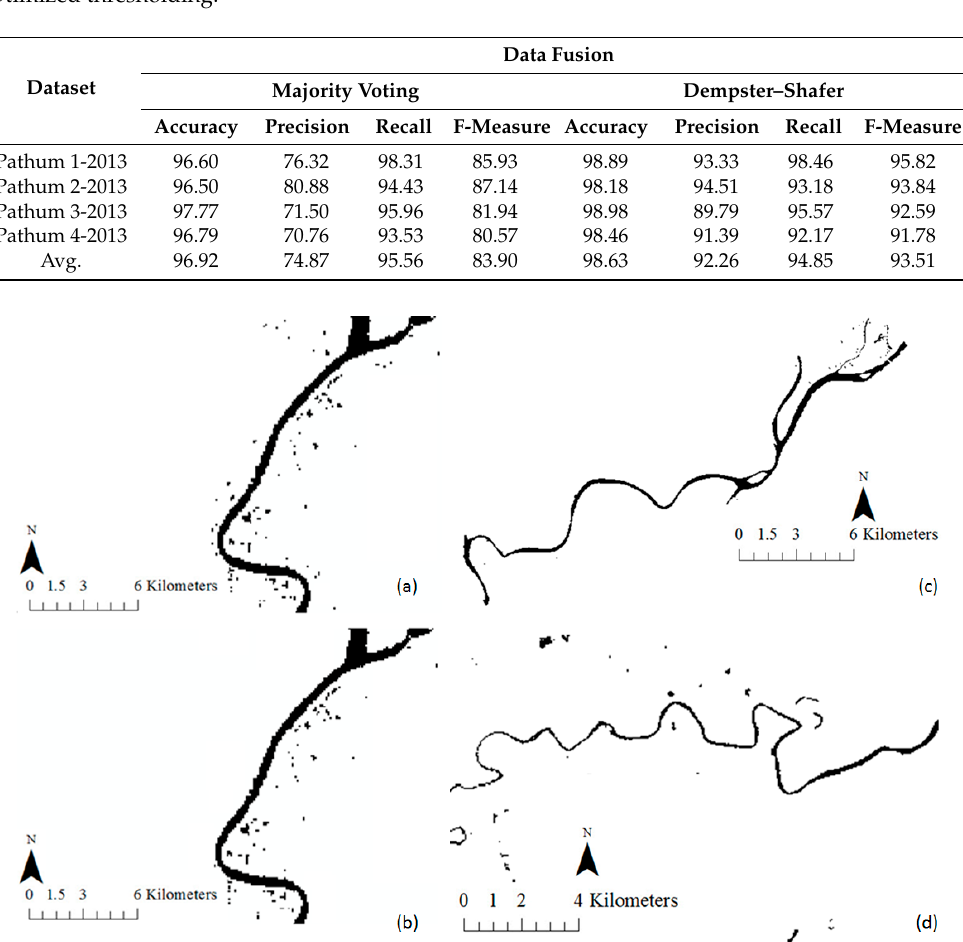
Figure 7. Water extraction results for the Pak Phanang River in Nakhon Si Thammarat) using: ( a ) Majority Voting; and ( b ) Dempster–Shafer. ( c ) The Tapi River in Surat Thani; and ( d ) the Lang Suan River in Chumphon using Dempster–Shafer.